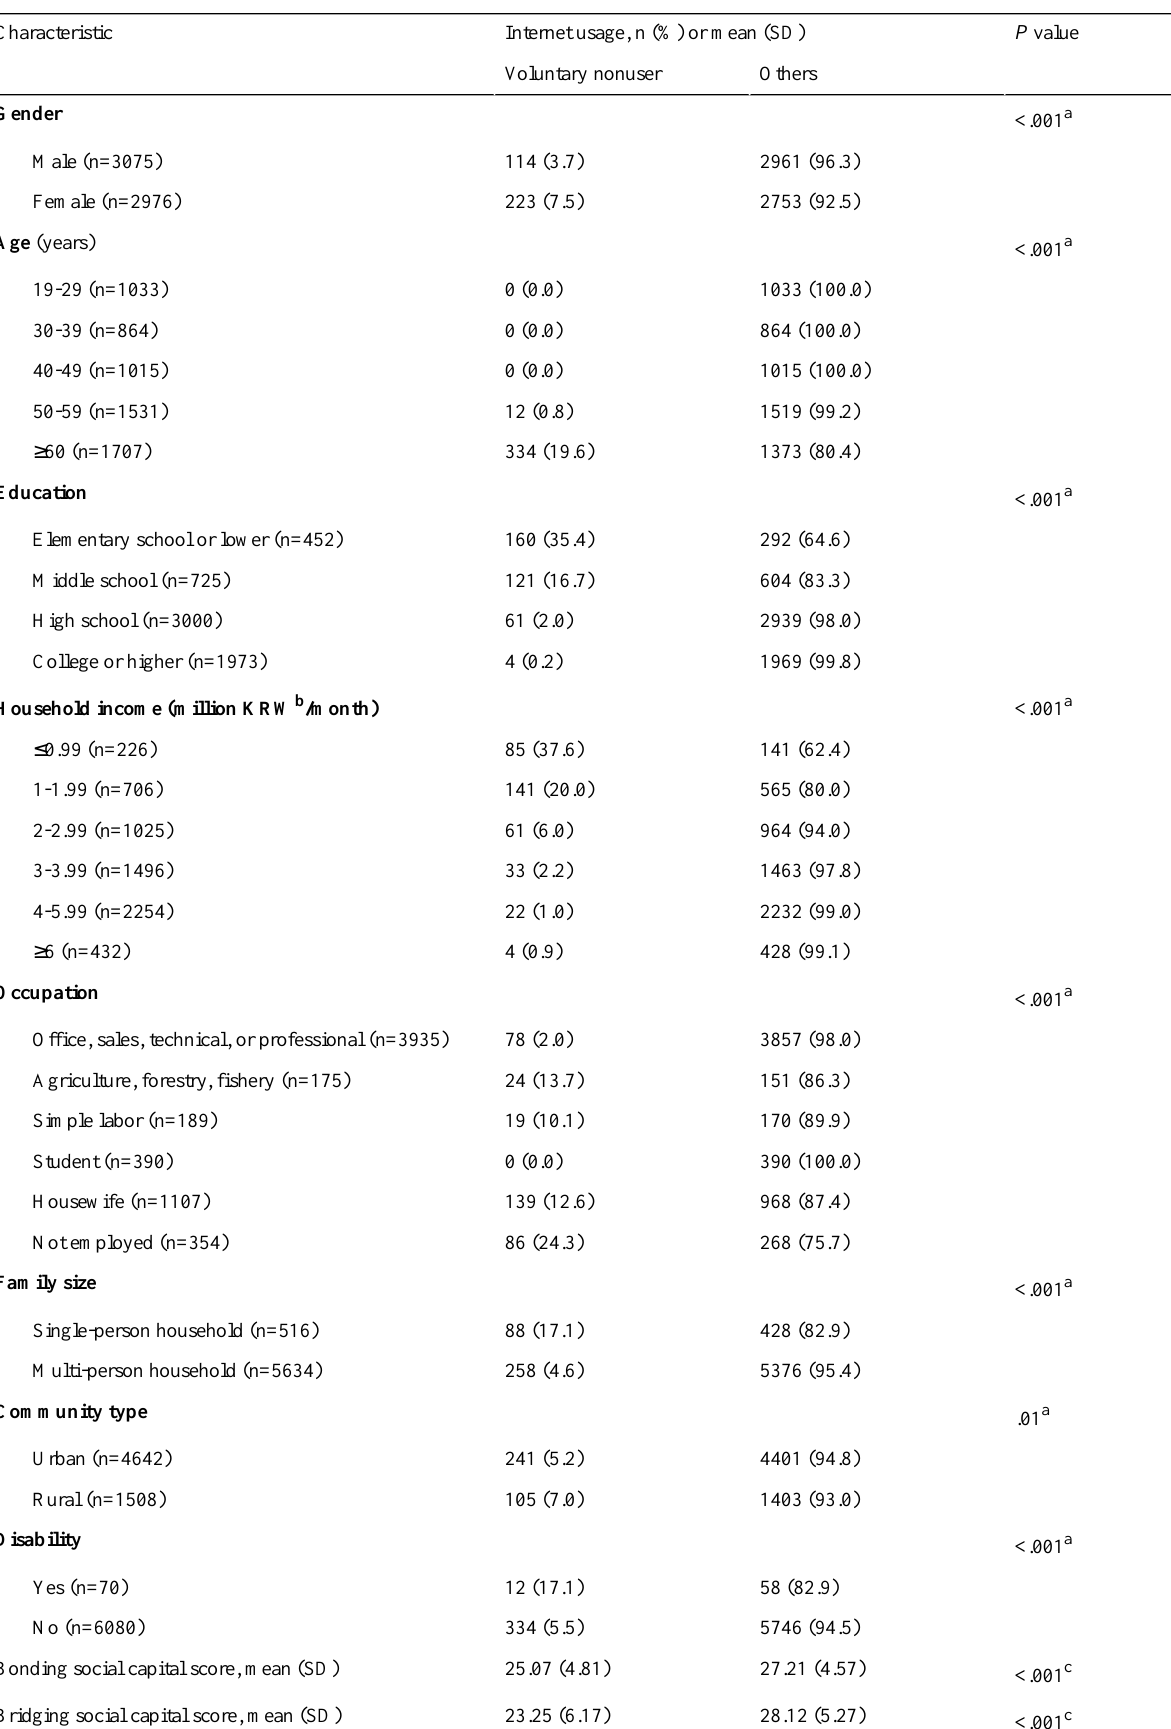
Table 2. Association between various factors and life satisfaction.